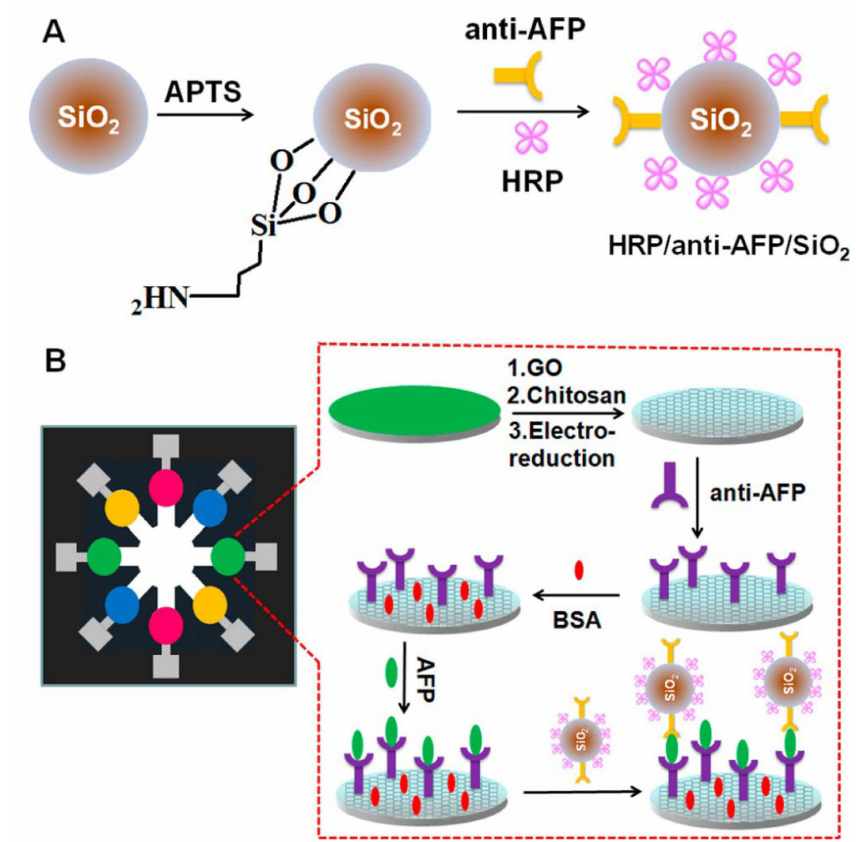
Figure 6. ( A ) HRP and Antibody modification on SiO 2 Nanoparticle surface. ( B ) Microfluidic Paper sensor structure and biomodification processes on the graphene oxide-based electrode surface in the sensor. Reprinted with permission from Ref. [91]. Copyright 2013, American Chemical